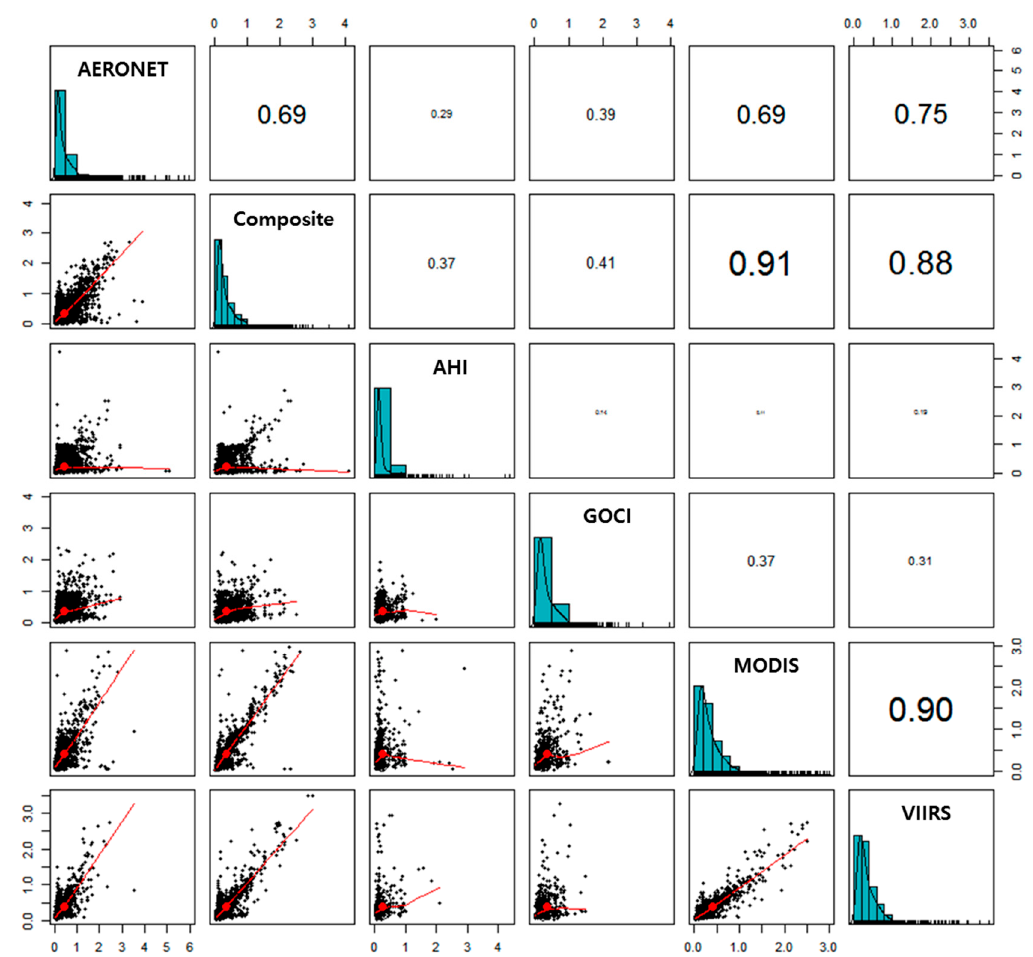
Figure 9. Bivariate Pearson correlation coefficients (r) between pairs of AERONET vs. composite and satellite data across Northeast Asia during 2017. Numerical values above the diagonal are linear correlation coefficients; scatter plots below the diagonal are of paired variables fit with a non-linear parametric smoothing function.